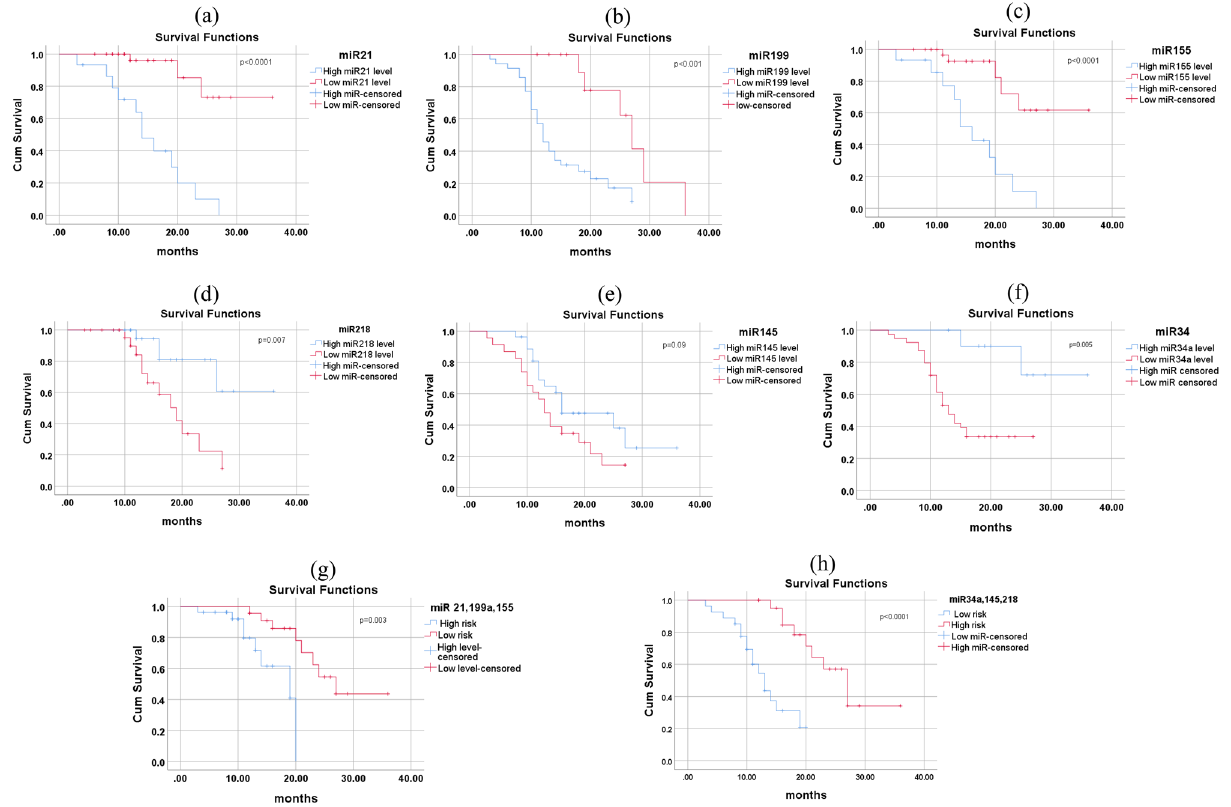
Figure 4. The correlation of miRNA expression with overall survival of cervical cancer patients calculated using Kaplan Meier curve and Log-rank test. The patients were stratified into high expression and low expression group according to median of each miRNA. ( a ) miR-21-5p, ( b ) miR-199a-5p, ( c ) miR-155-5p, ( d ) miR-218-5p, ( e ) miR-145-5p, ( f ) miR-34a-5p, ( g ) three upregulated miRNA signatures, and ( h ) three downregulated miRNA signatures. The patients were stratified into high-risk group and low risk group based on